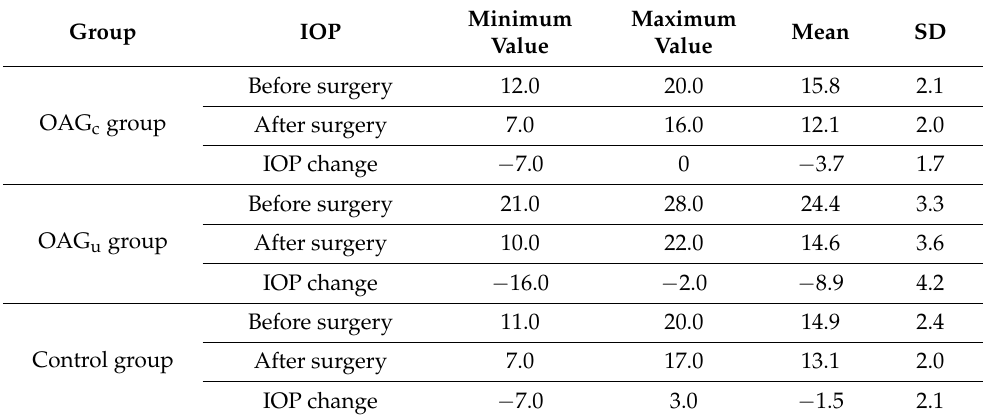
Table 3. IOP changes 6 months after cataract